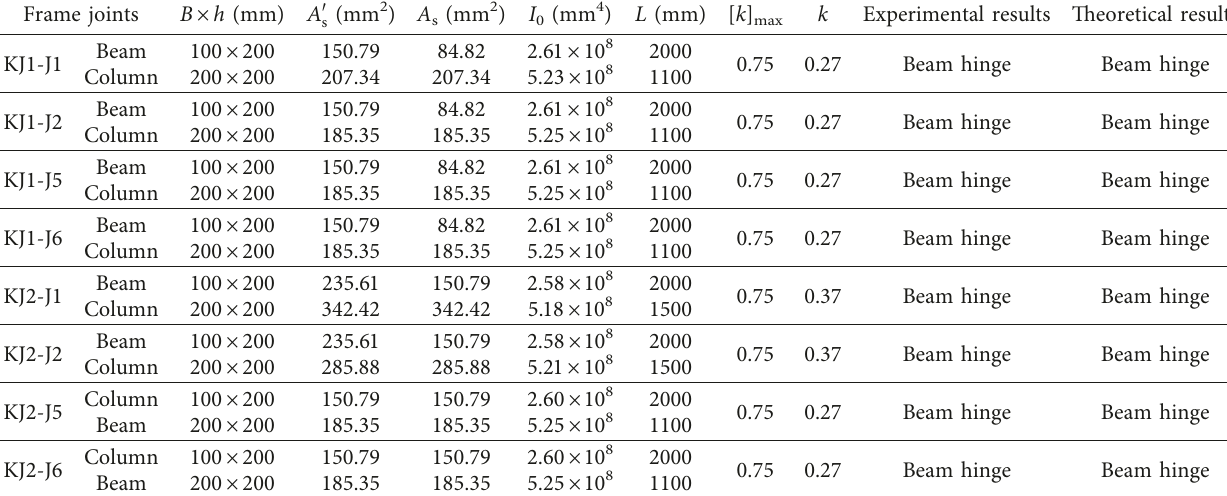
Table 4: Comparison of experimental phenomena and theoretical judgement. Frame joints k Experimental results Theoretical